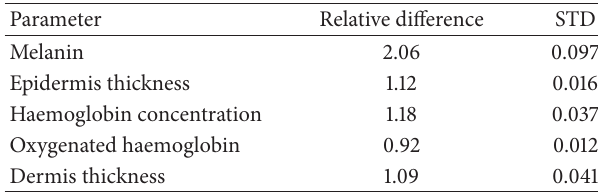
Table 6: Average difference between melasma and healthy skin.